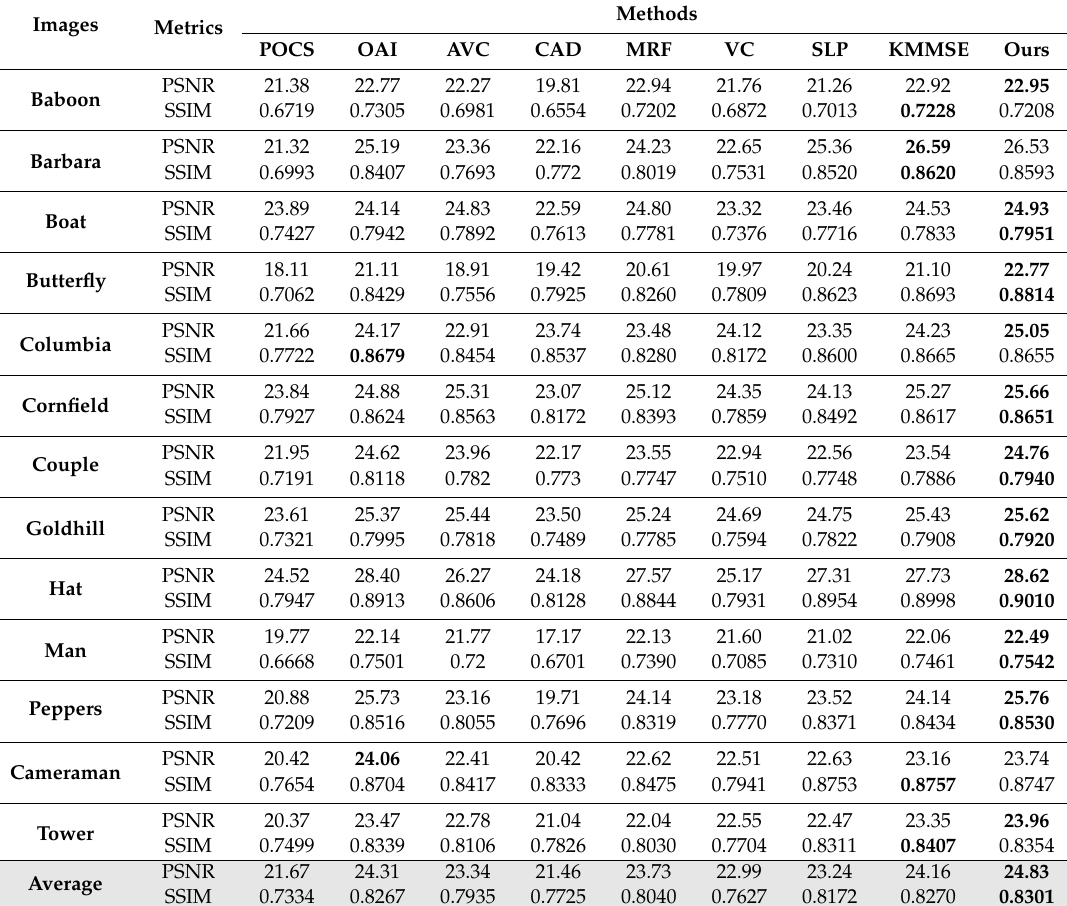
Table 3. PSNR and SSIM comparison of EC algorithms with 16 × 16 regular consecutive block